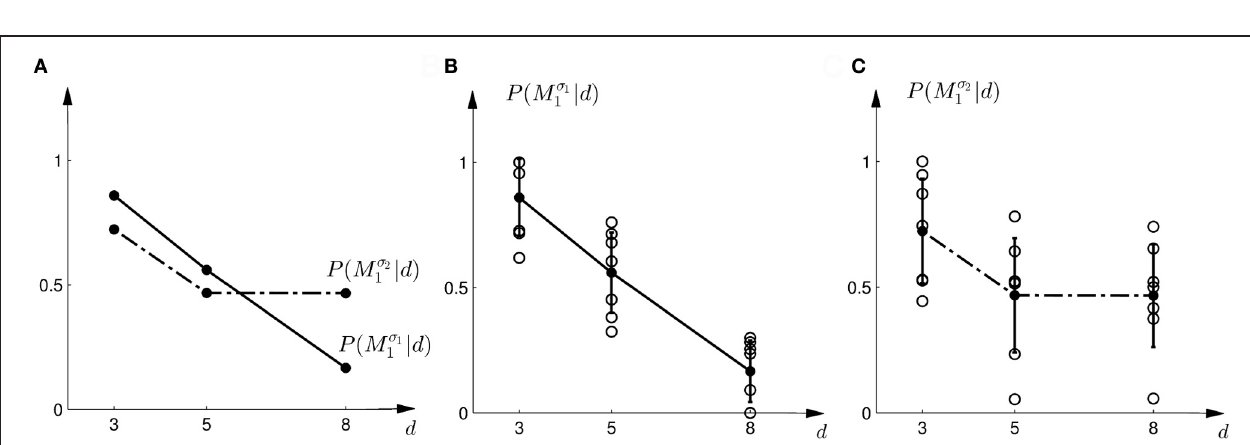
probability of choosing M σ 1 1 . Circles represent individual subjects’ choice probabilities, the solid line shows the average over participants with standard deviation error bars. With increasing array size, the probability of choosing M σ 1 1 decreases. (C) Shows the experimentally observed choice probabilities P ( M σ 2 1 | d ) for the second part of the experiment, where σ 2 > σ 1 . Compared to the first part, the probability of choosing M σ 2 1 for the large array size d = 8 is significantly increased.